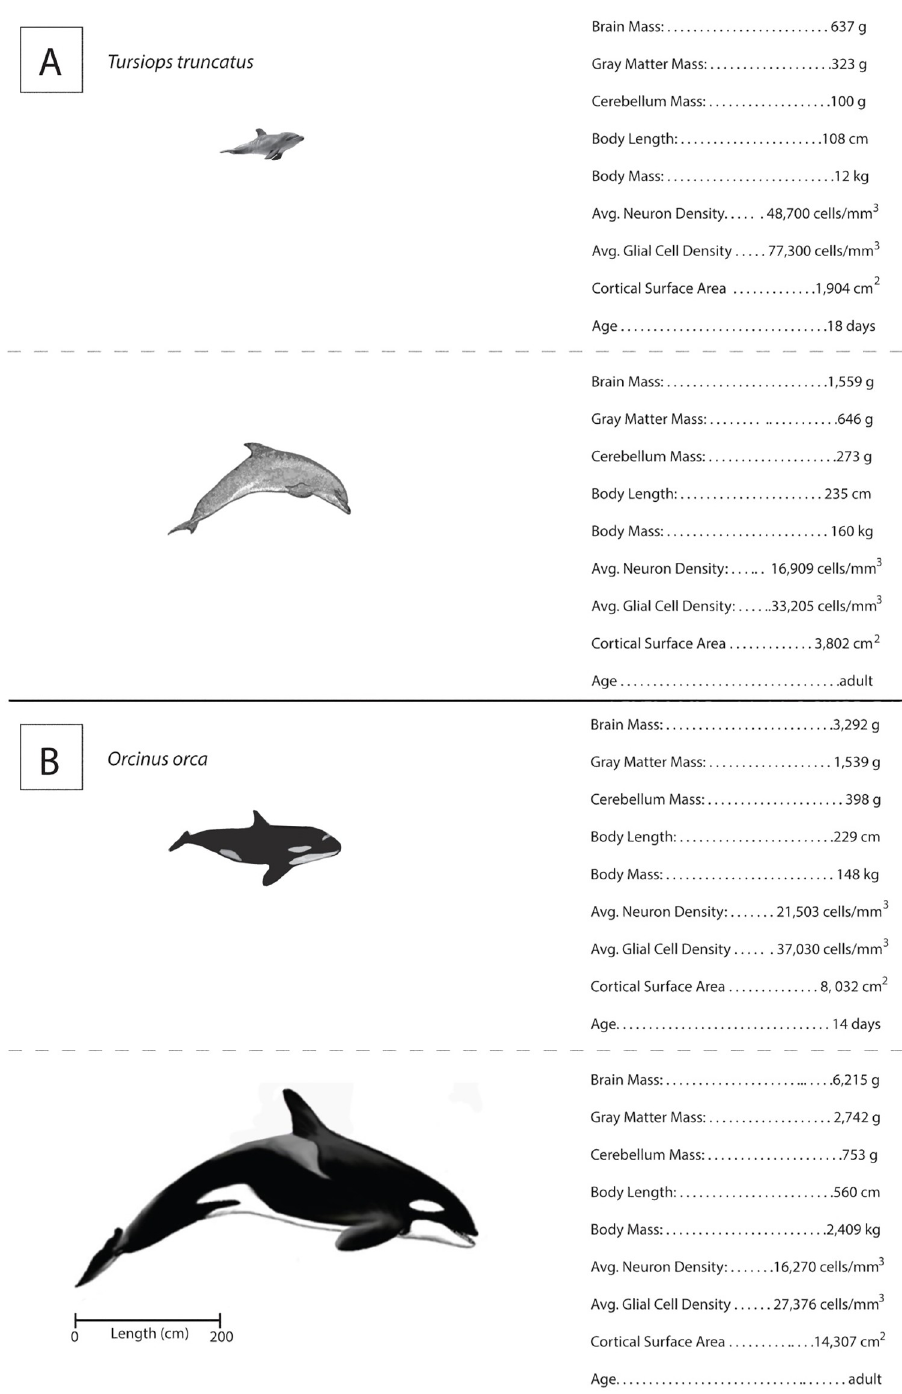
Fig 6. Distribution of total brain mass for mature Oo , Tt , Dd , Zc , and H . sapiens . Each bar represents the percentage of total brain mass in the cerebellum (pink), gray matter of the cerebral cortex (green), and the remaining areas of the brain (ROB: brainstem, white matter of the cerebral cortex) are shown in blue. Mass of the gray matter was calculated by multiplying the cortex surface area and cortex thickness (see S1 Table) by the specific gravity of the gray matter of the cerebral cortex [52]. For average cortex thickness and surface area we used our own measurements. For the human cortex thickness, we used a value of 2.5 mm. The calculated values here are similar to H . sapiens values averaged from previously published data [74]. Cerebellum masses are values from a previous publication [37]. Kb was not included because we only had a brain from an immature animal.